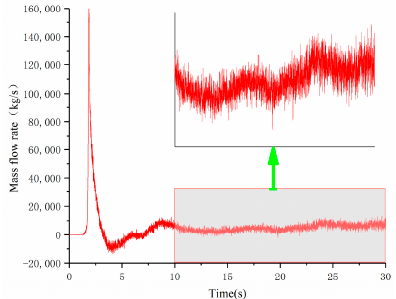
Figure 14. Curve of particle mass flow with time in 800,000-mesh model.